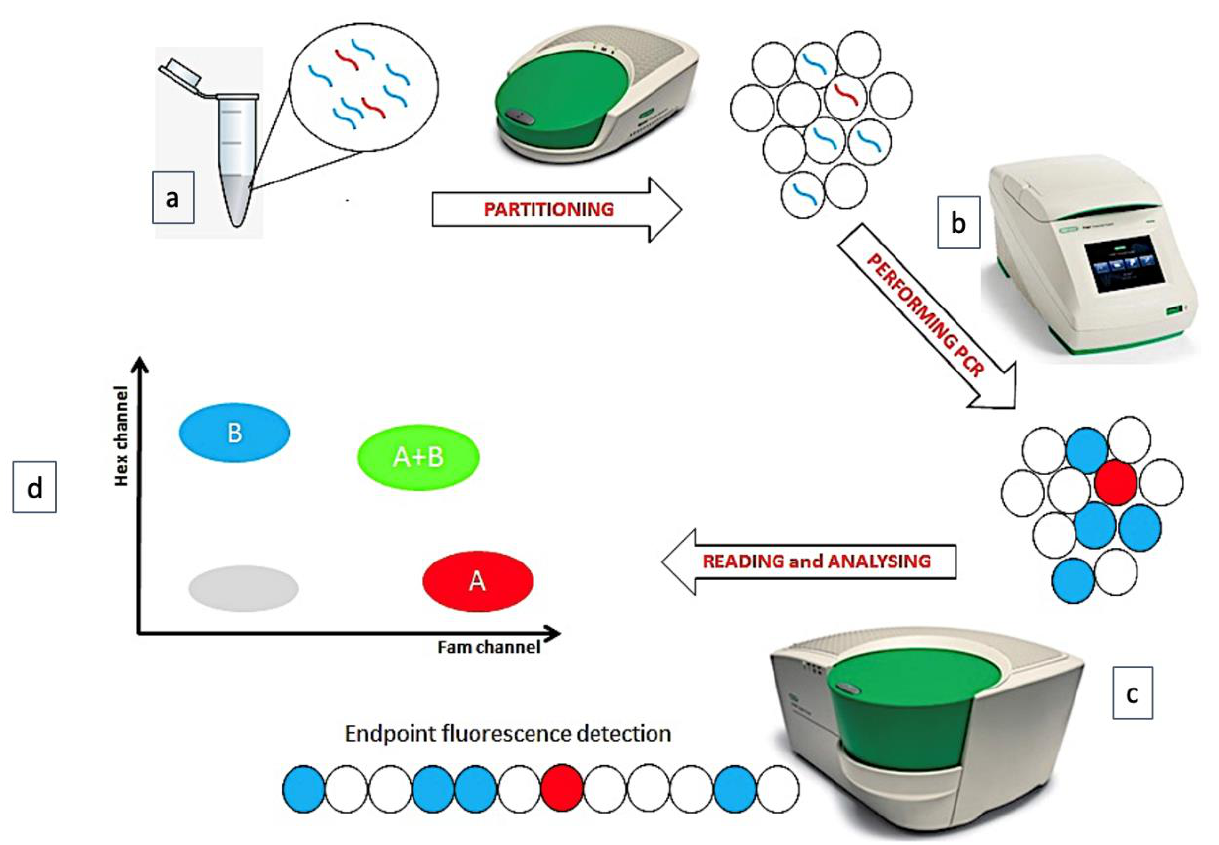
Figure 1. The phases of ddPCR technique. ( a ) The sample is partitioned in many thousands of droplets. ( b ) In each droplet a target is amplified. ( c ) The endpoint amplification results are analyzed. ( d ) A plot is generated, reading 2 fluorescence channels.